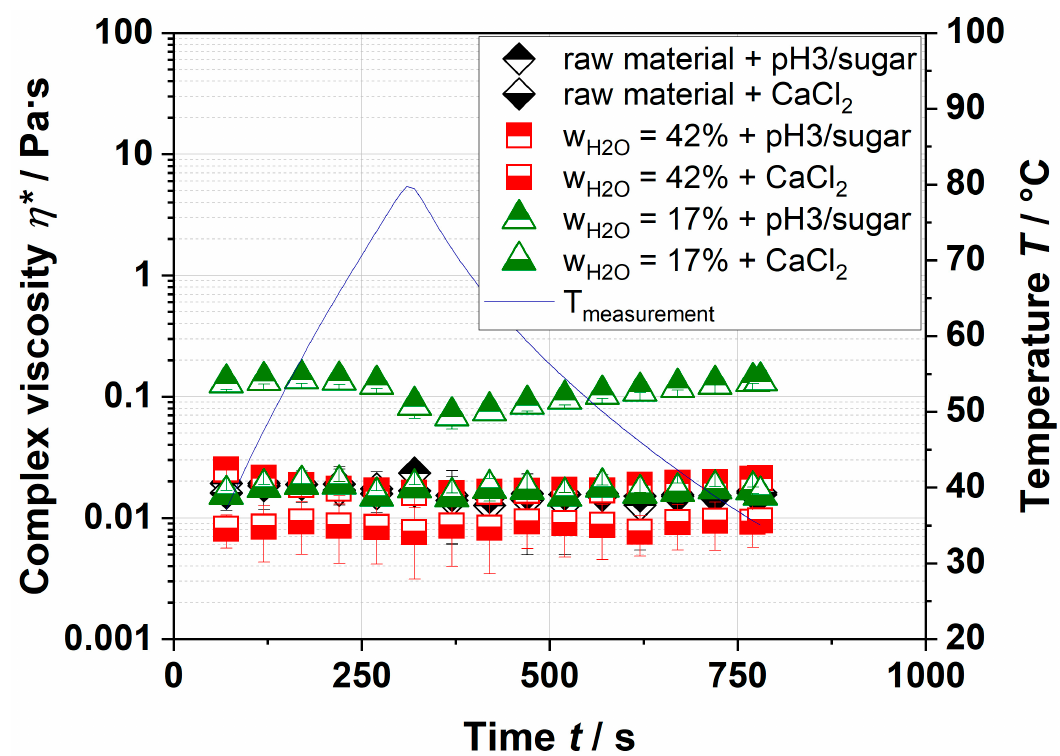
Figure 3. Gelation kinetics of extracted and resolved pectin with the addition of CaCl 2 or sugar at pH 3. The extrusion process parameters of the extruded sample were water contents of 42 and 17%, and a screw speed of 700 min − 1 . The blue line depicts the temperature ramp of